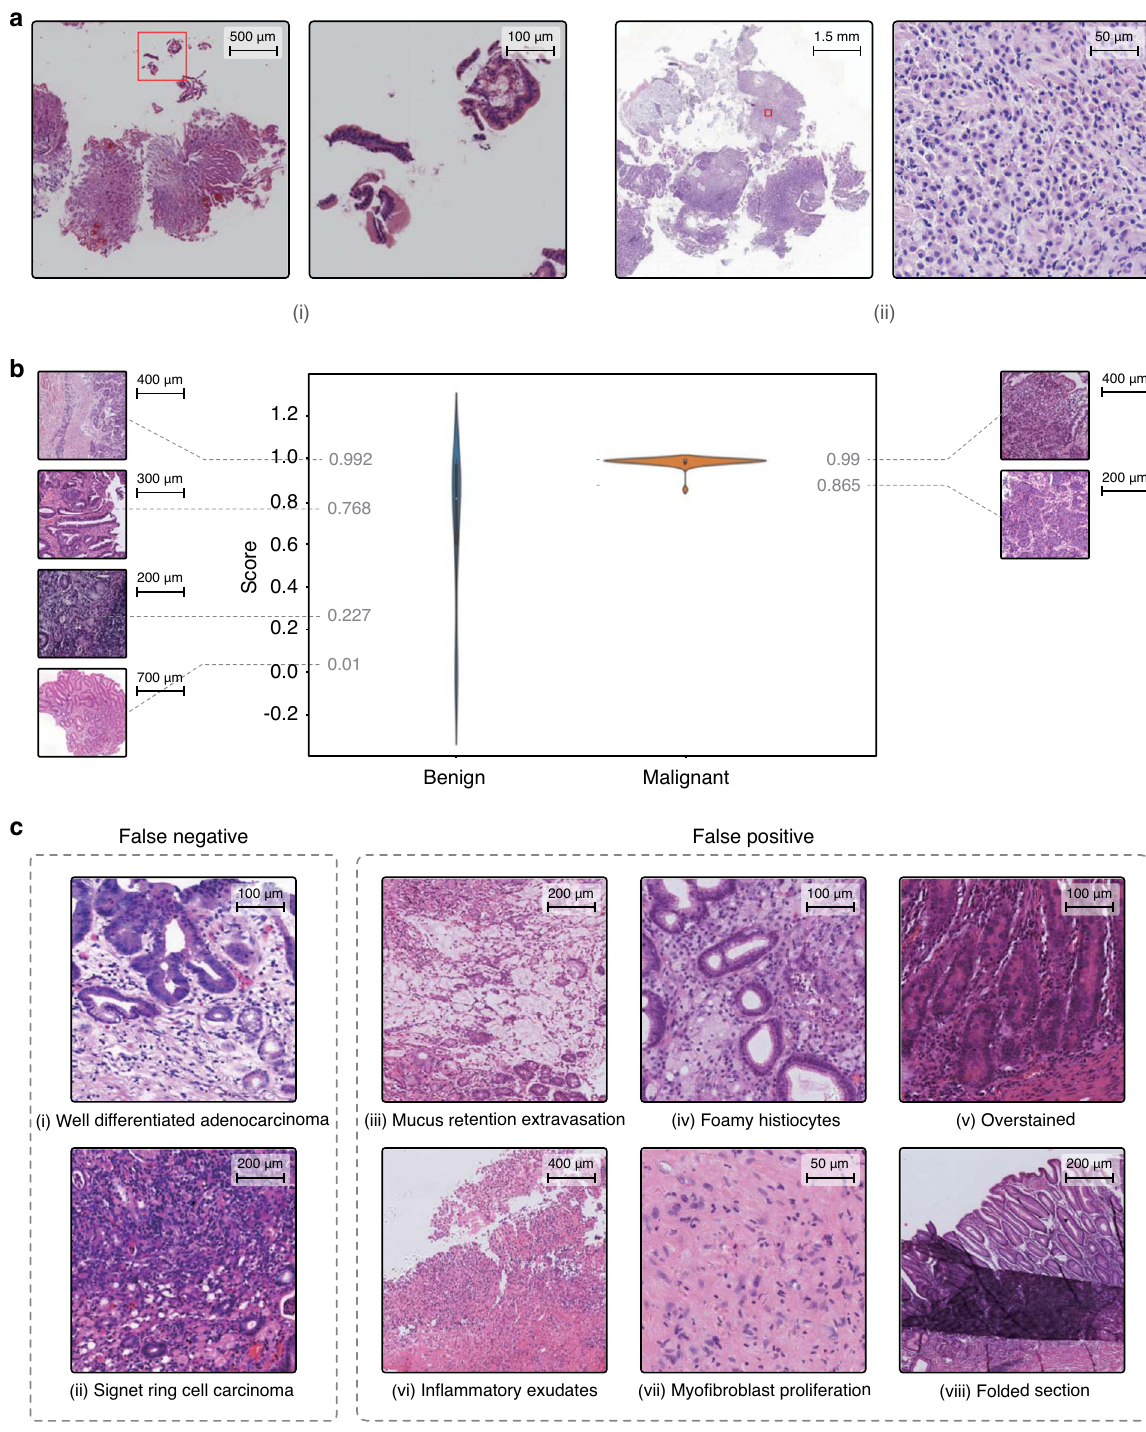
Fig. 2 Highlights of the deep learning model. a Two cases detected by the AI assistance system that were initially misdiagnosed by pathologists. b Violin plot of the probability distributions for the malignant and benign cases in the IHC dataset. c Eight examples of false negative and false positive cases. The experiment was performed fi ve times, and we obtained the same